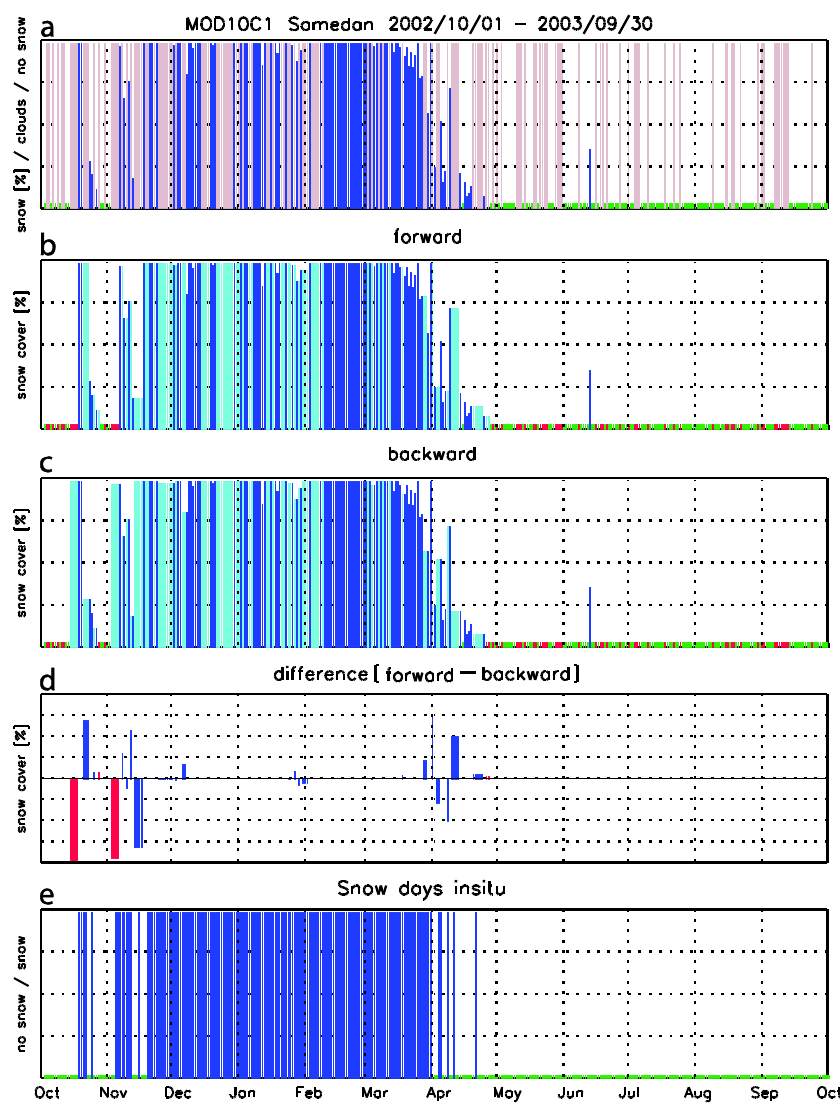
Fig. 4. Processing steps to derive the yearly number of snow days based on the MOD10C1 product (a) by including a forward (b) and backward (c) gap-filling approach. Artificially added snow days (light blue) and days with no snow (light red) are indicated. The differences resulting from the cloud removable technique are visualized (d) with red bars showing a contrary gap-filling and with blue bars showing a consistent gap-filling (i.e. forward (b) and backward (c) indicate snow). The temporal variability of snow days calculated from in situ observations is demonstrated (e). The period from 1 October 2002 to 30 September 2003 is presented.